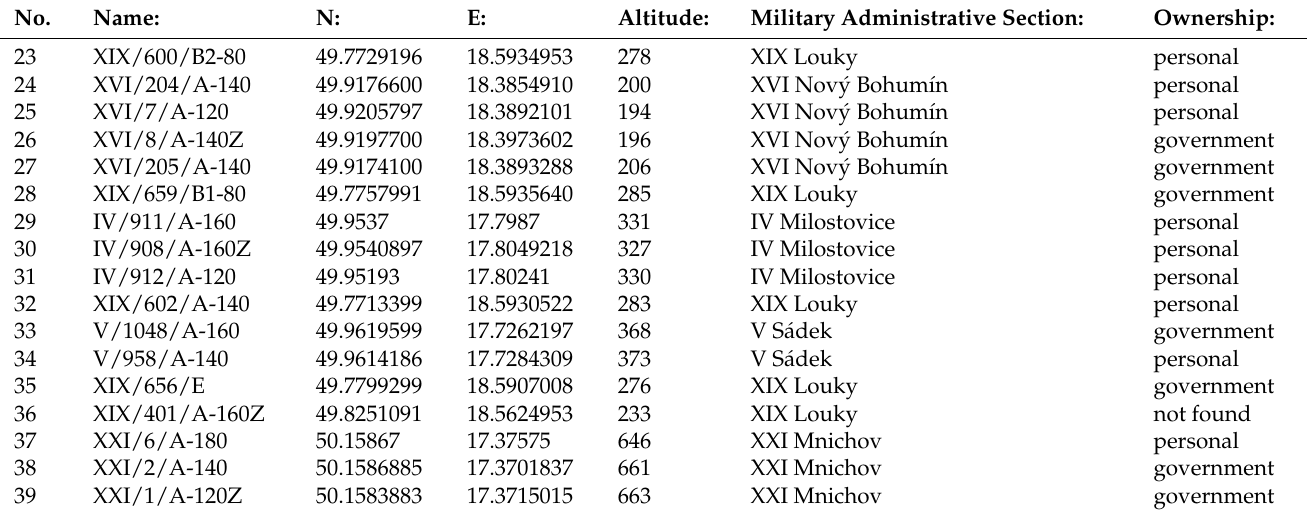
Table A2. Overview table of SA-CEFs studied objects with their description. The numbering of the individual SA-CEFs corresponds to the data in Table 1—part